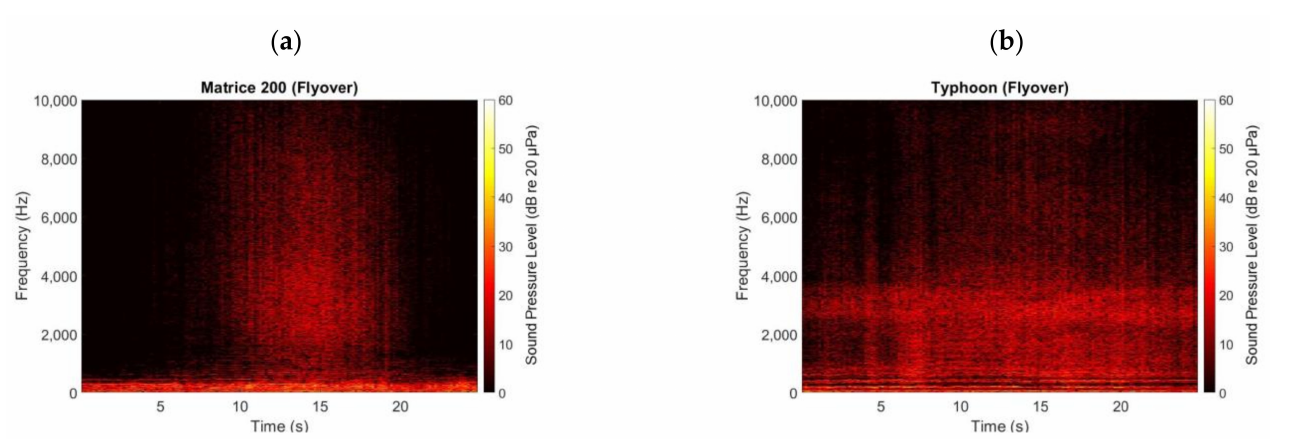
Figure 2. Spectrogram of the DJI M200 ( a ) and Yuneec Typhoon ( b ) UAVs flying over at ~50 m (~150 ft) altitude above the microphone [9].